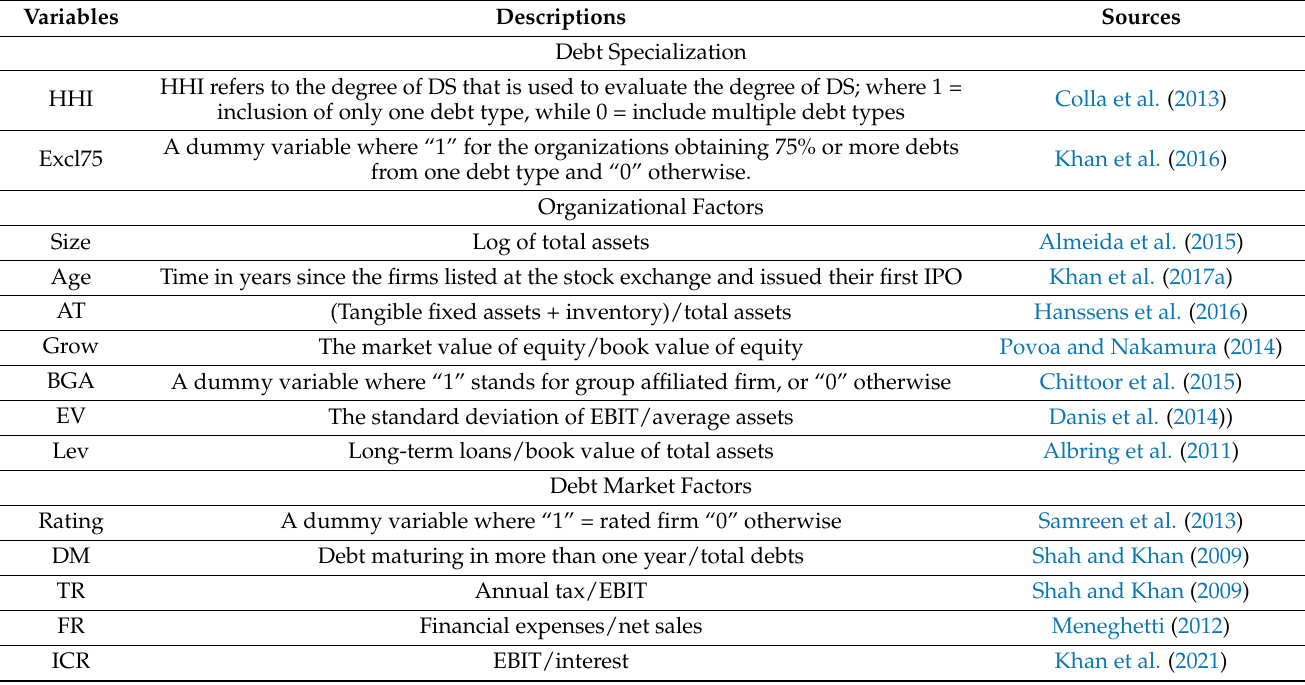
Table 1. Mnemonics, definitions, and sources of